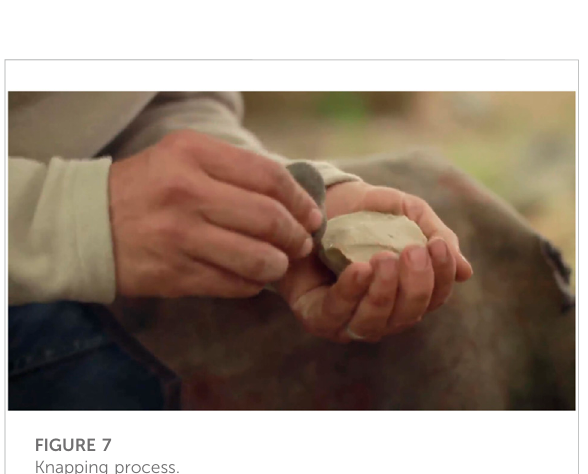
FIGURE 7 Knapping process.